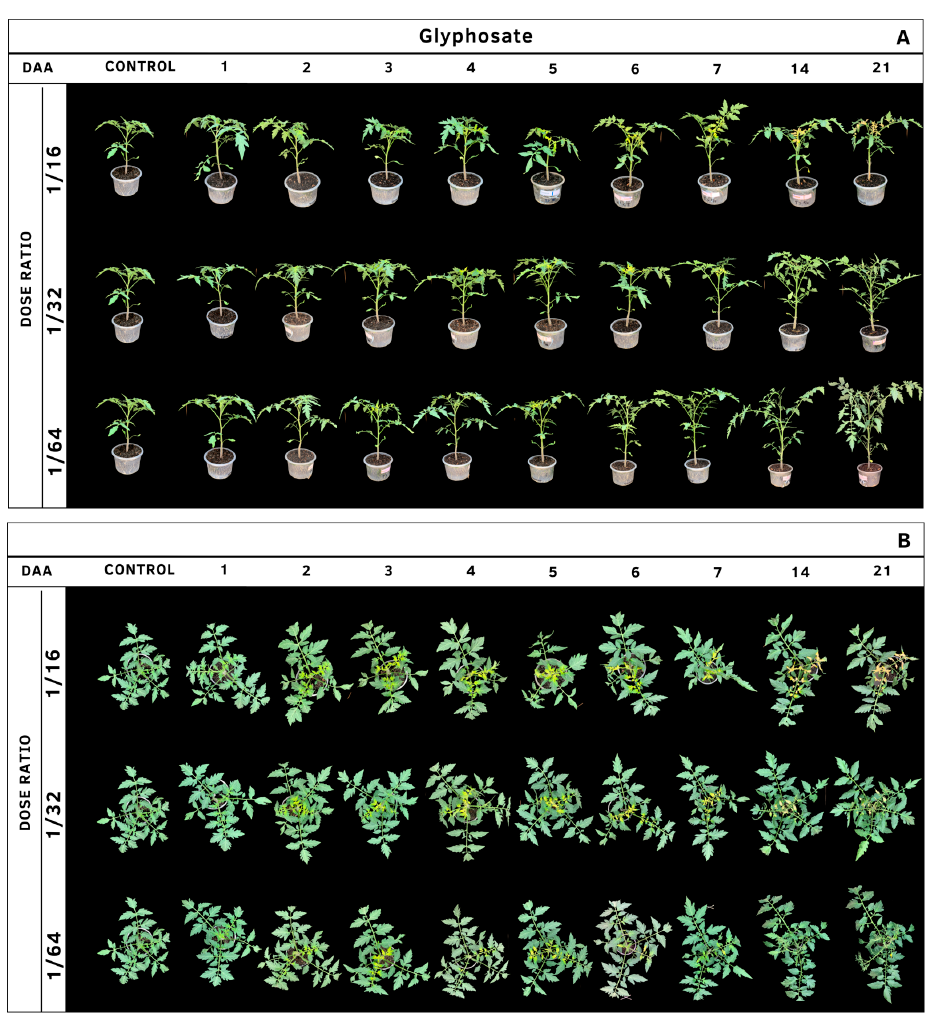
Figure 5. Symptoms evolution in tomato plants due to simulated glyphosate drift at dose ratios 1/16D, 1/32D, and 1/64D (138.75, 69.38, and 34.69 g a.e. ha − 1 , respectively) of the recommended dose (D). Evaluations were made from 1 to 7, 14, and 21 days after application (DAA). Front view ( A ) and top view ( B ) of tomato plants a ff ected by simulated drift.